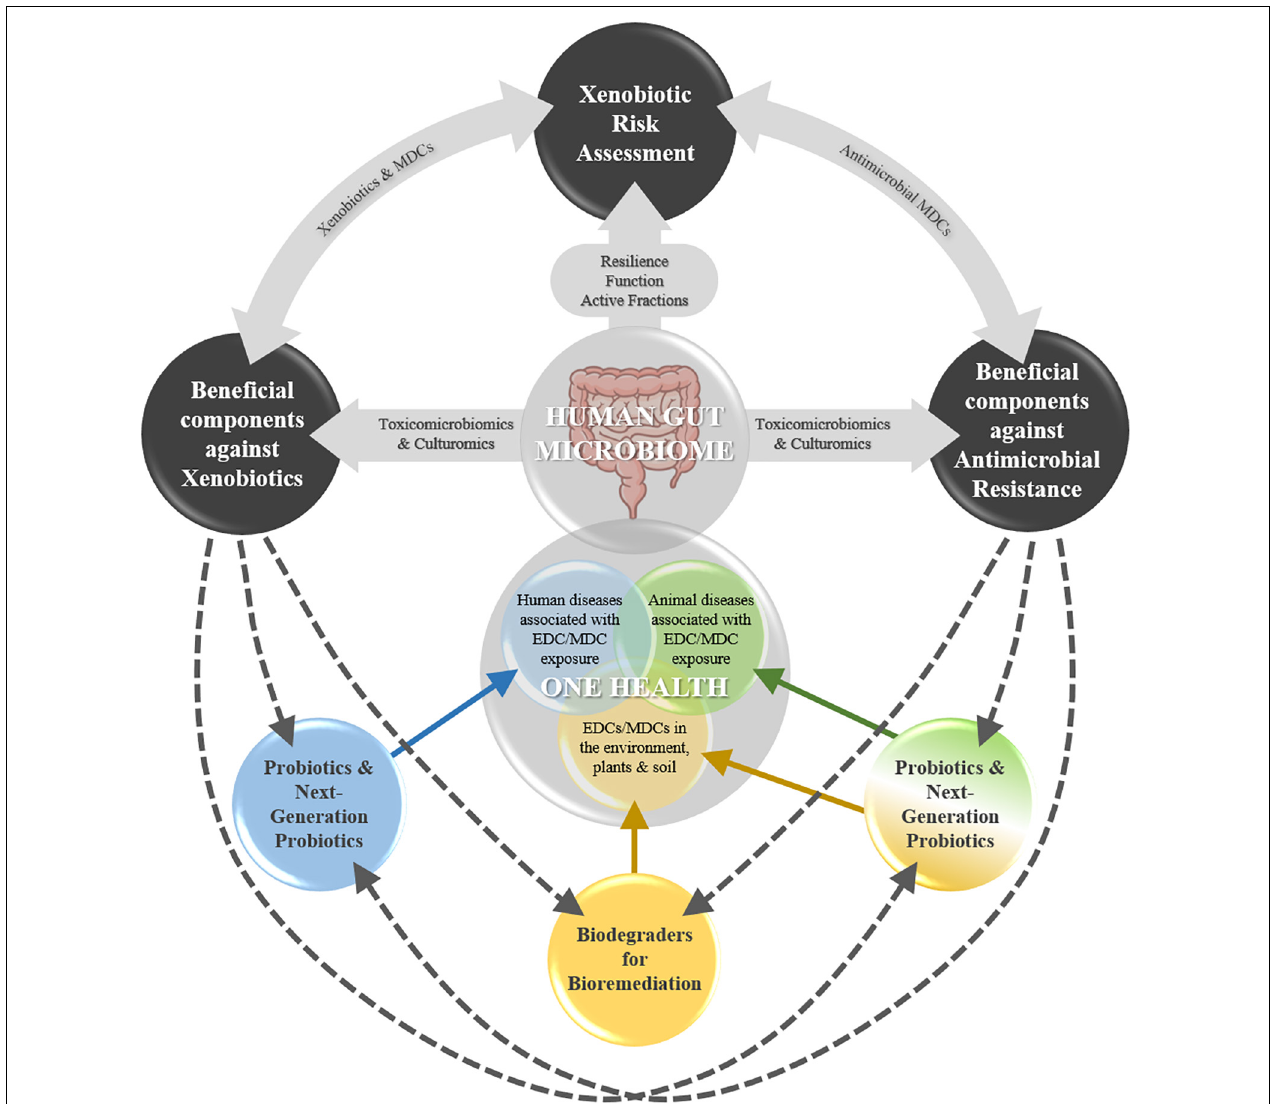
FIGURE 1 | Three interlinked areas of relevance to the human gut microbiome (GM) in the context of One Health (OH); incorporation of the GM in food safety risk assessment of xenobiotics; identification and application of beneficial GM taxa and components (e.g., enzymes and bioactive compounds) to various areas under OH, and; specifically, in the context of antimicrobial resistance. EDC, endocrine disrupting chemicals; MDC(s), microbiota disrupting